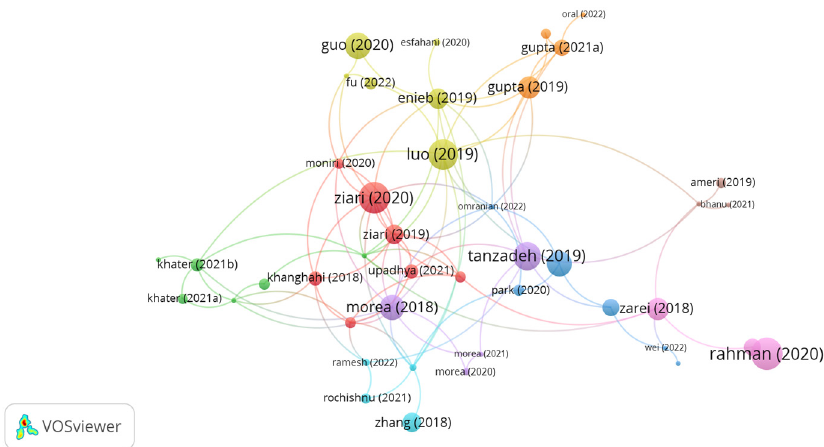
Figure 5. Network visualization of glass fibers.